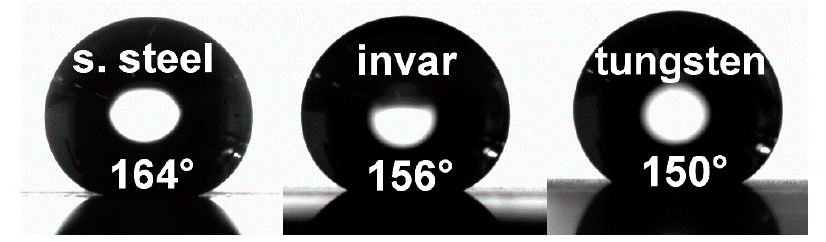
Figure 8 . The wettability measurements of laser processed samples after vacuum treatment. Figure 8. The wettability measurements of laser processed samples after vacuum